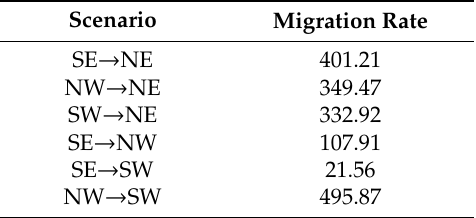
Table 8. Gene flow between pairs of four populations (NE, SE, NW, and